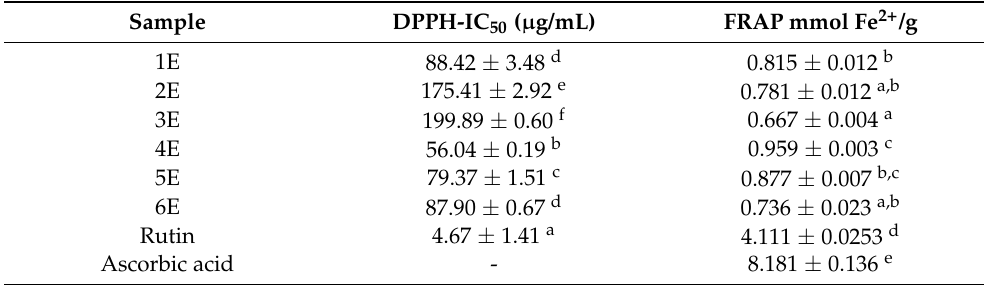
Table 5. Total antioxidant activity and 2,2-diphenyl-1-picrylhydrazyl (DPPH) radical scavenging activity in methanolic extracts of Hyssopus officinalis subsp. aristatus . Different letters in the superscript indicate statistically different values at p <